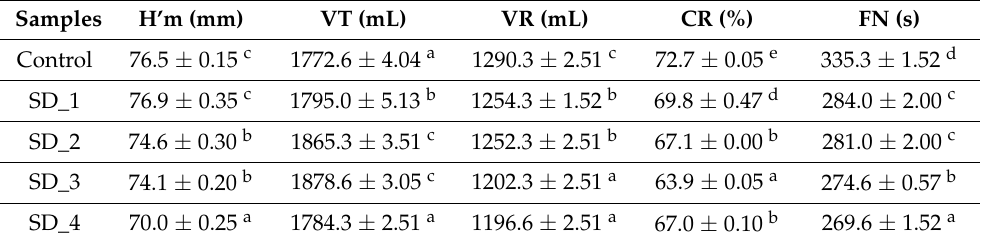
Table 4. Rheofermentometer parameters and Falling Number values of dough samples with different levels of dry sourdough (SD)